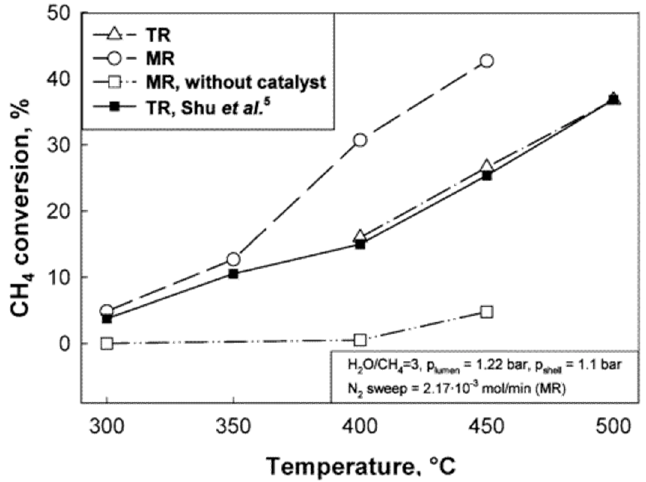
Figure 7. Methane conversion versus temperature for both conventional / traditional (TR) and membrane reactors (MR) [24].